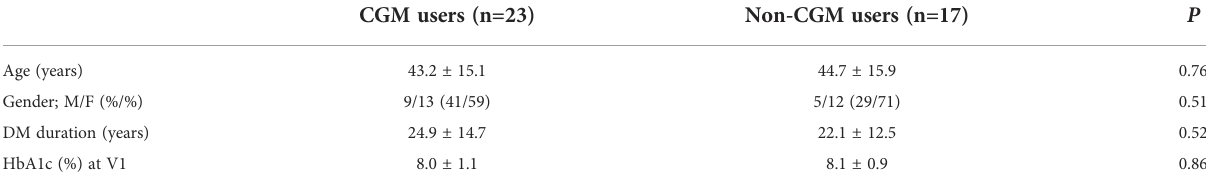
TABLE 1 Characteristics of CGM users and non-CGM